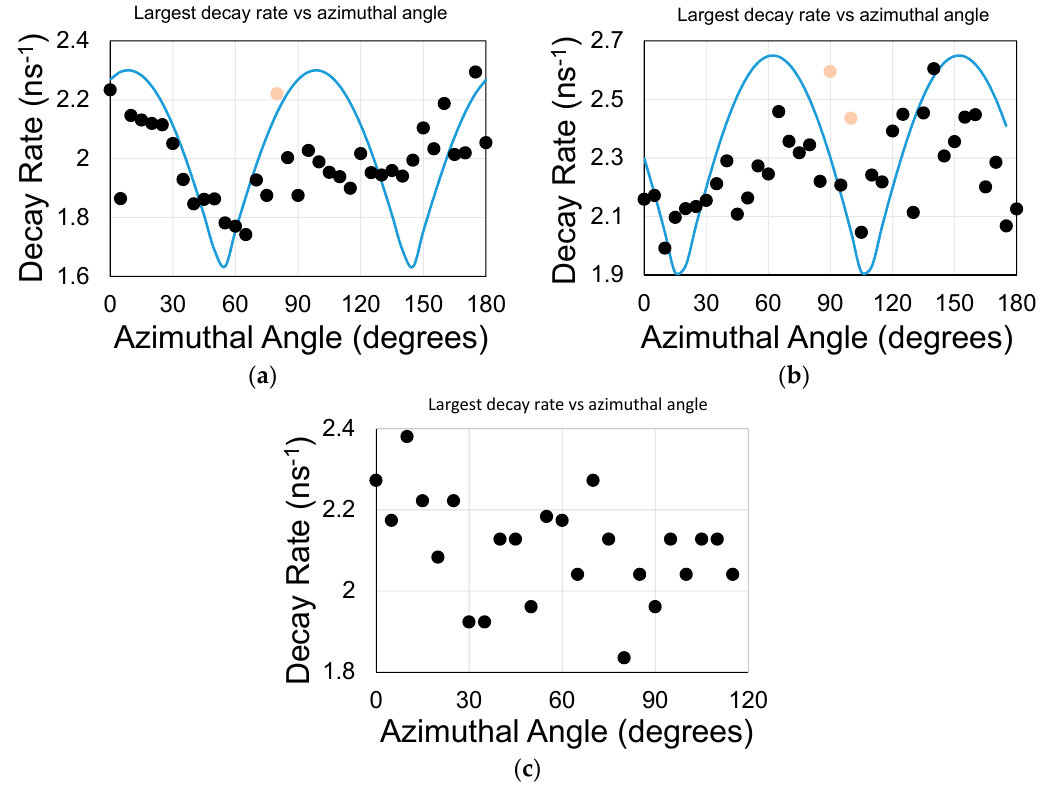
Figure 6. ( a ) Sample S8 (QDs in the holes under the graphene guide) and ( b ) sample S9 (QDs on top of the 10-nm hafnia on the graphene guide). The QDs were spun over the samples. The blue line is the expected undulations and a guide for the eyes. The red dots indicate outliers: a solution was achieved with a good R square value of above 0.97 but residuals were not evenly distributed about the mean (see SI Section). ( c ) Maximizing the fluorescence signal (as opposed to focusing onto the sample surface) resulted in decay rates that covered similar value range to ( b ) but failed to uncover meaningful undulations.